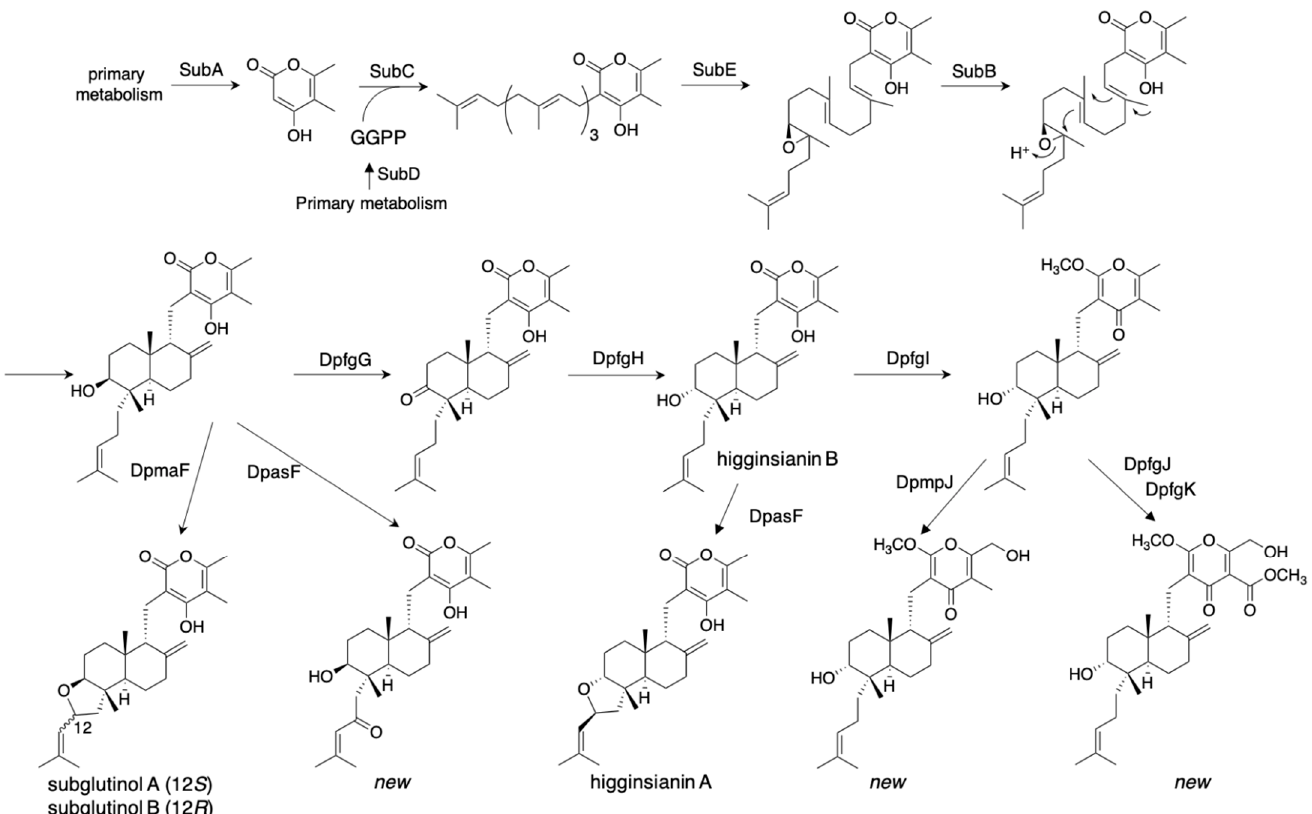
Figure 8. Combinatorial biosynthesis of diterpenoid pyrones in A. oryzae .